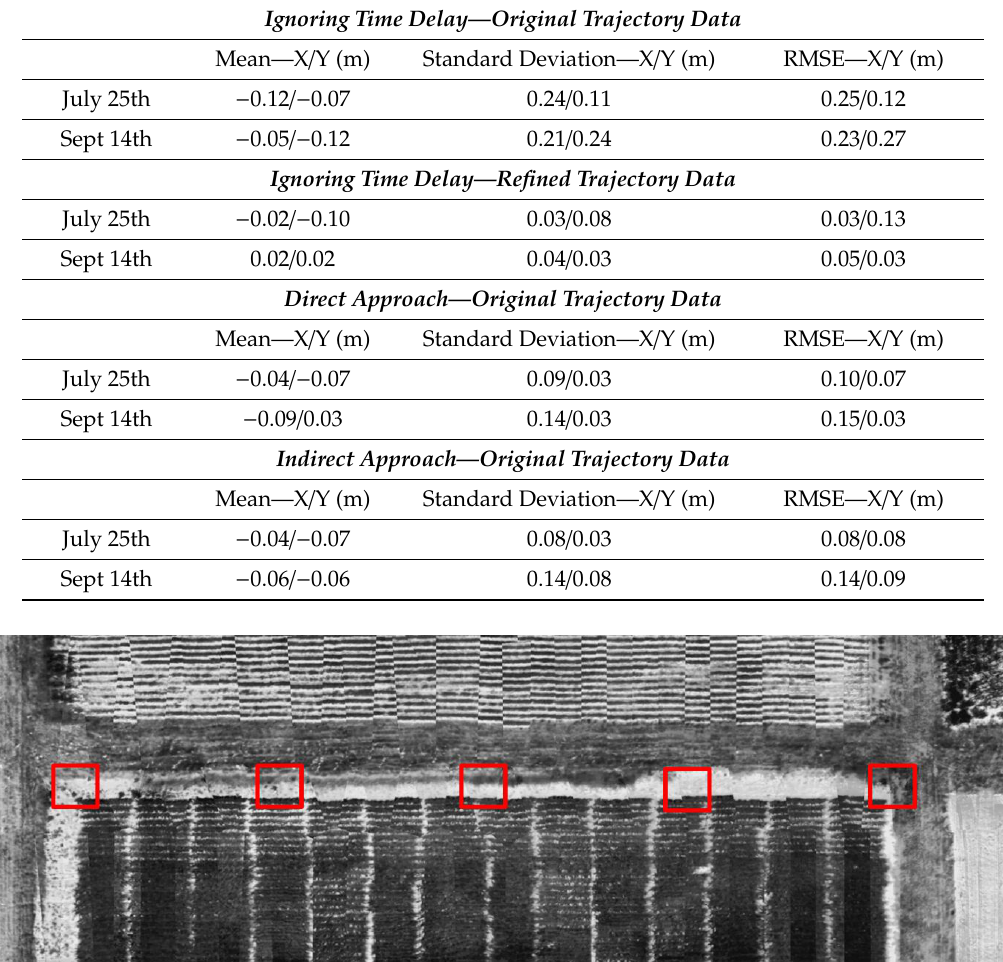
Table 9. Derived statistics of horizontal / planimetric coordinate di ff erences for the five check points derived from the orthophoto from the DJI M200 thermal platform.